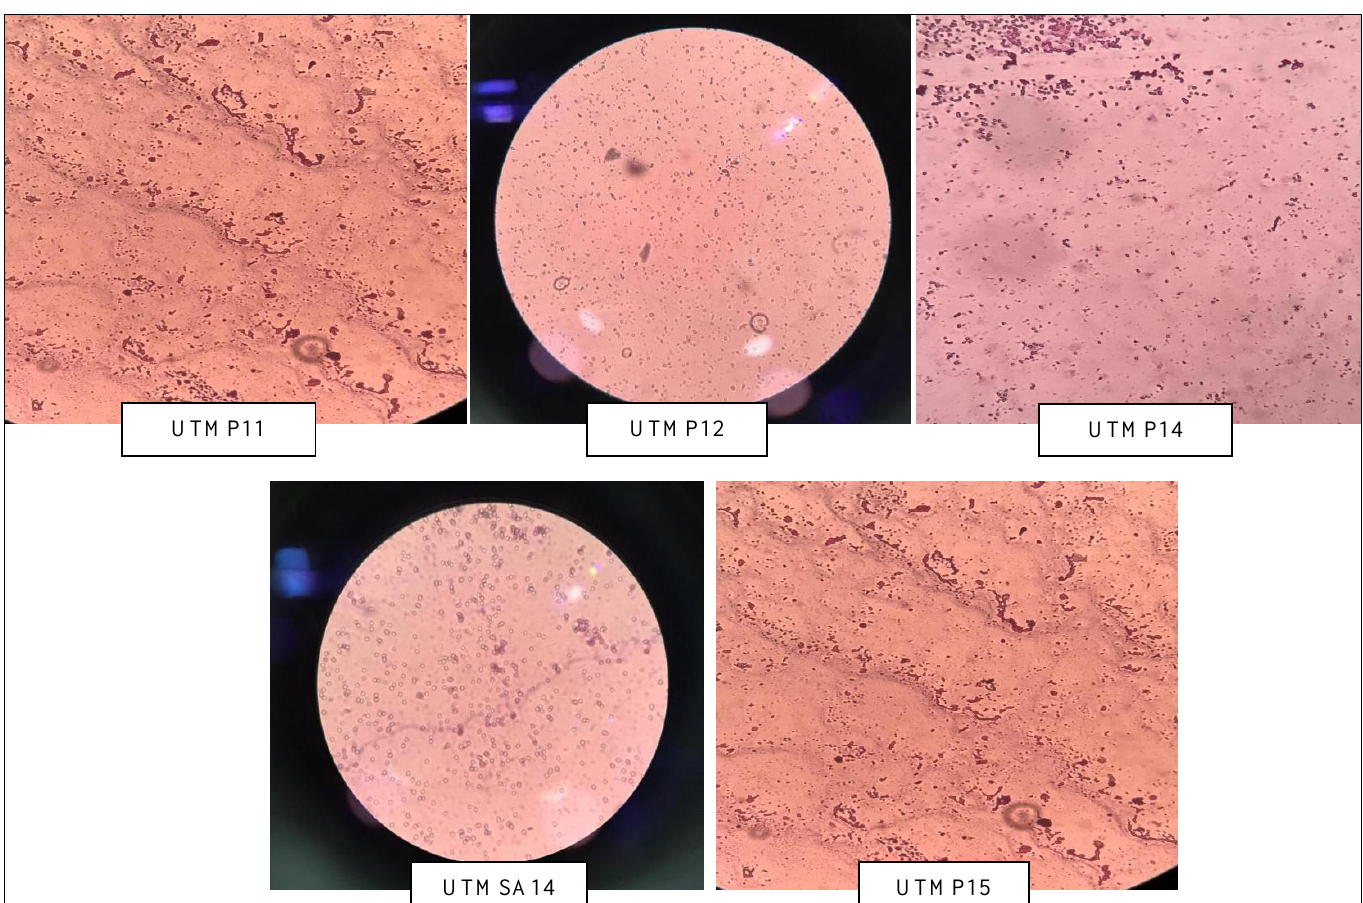
Figure 2: Morphological test results for microscopic observations of Bacillus subtilis UTMP11, Bacillus subtilis UTMP12, Bacillus tequilensis UTMP14, Bacillus tequilensis UTMSA14 and Bacillus subtilis UTMP15. Source: Authors,